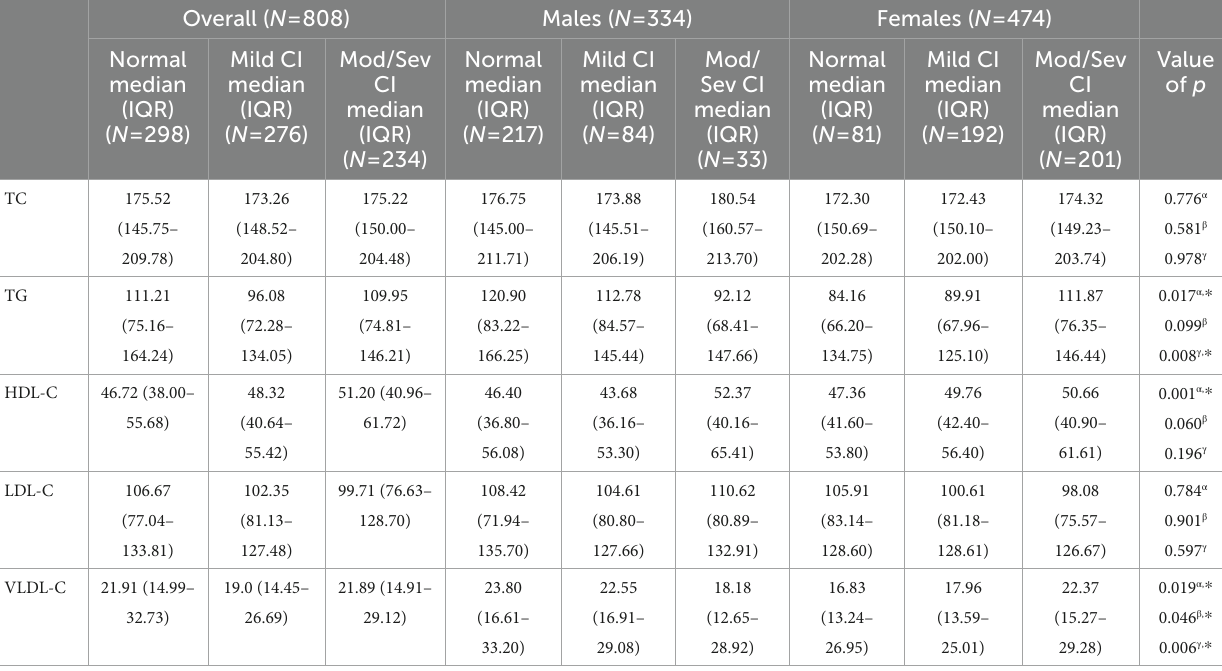
TABLE 2 Overall and sex-stratified distribution of median blood lipid levels with respect to cognitive